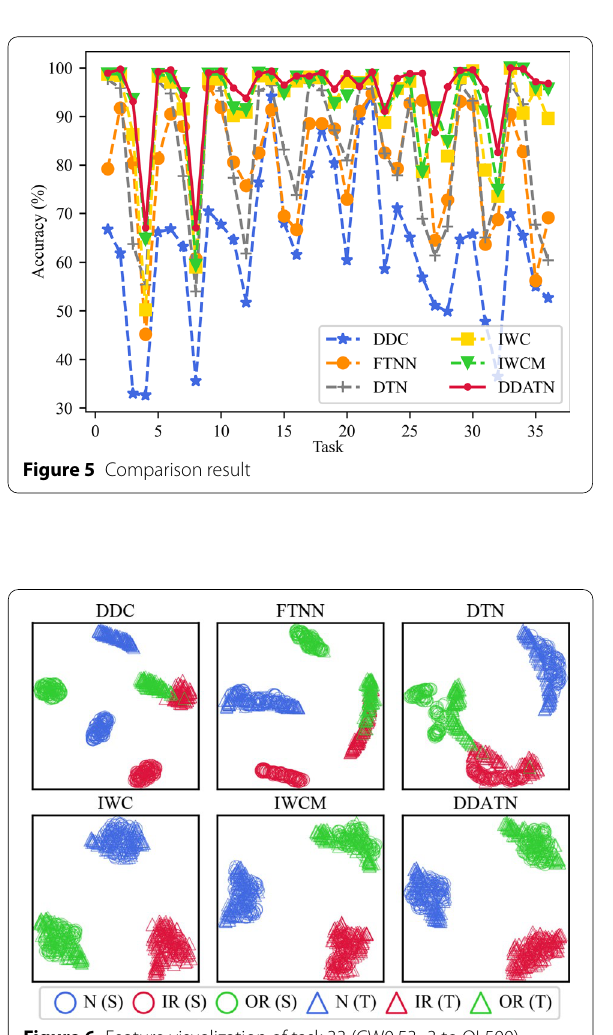
Figure 6 Feature visualization of task 33 (CW0.53_3 to OL500)